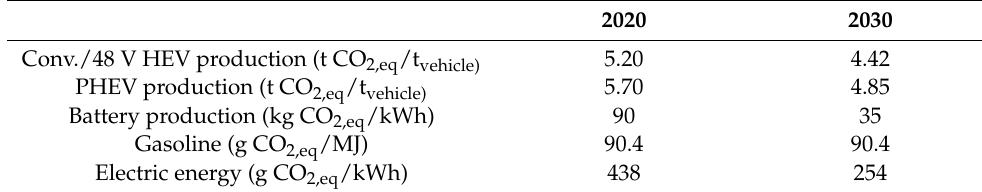
Table 4. LCA emissions for the production phase and energy